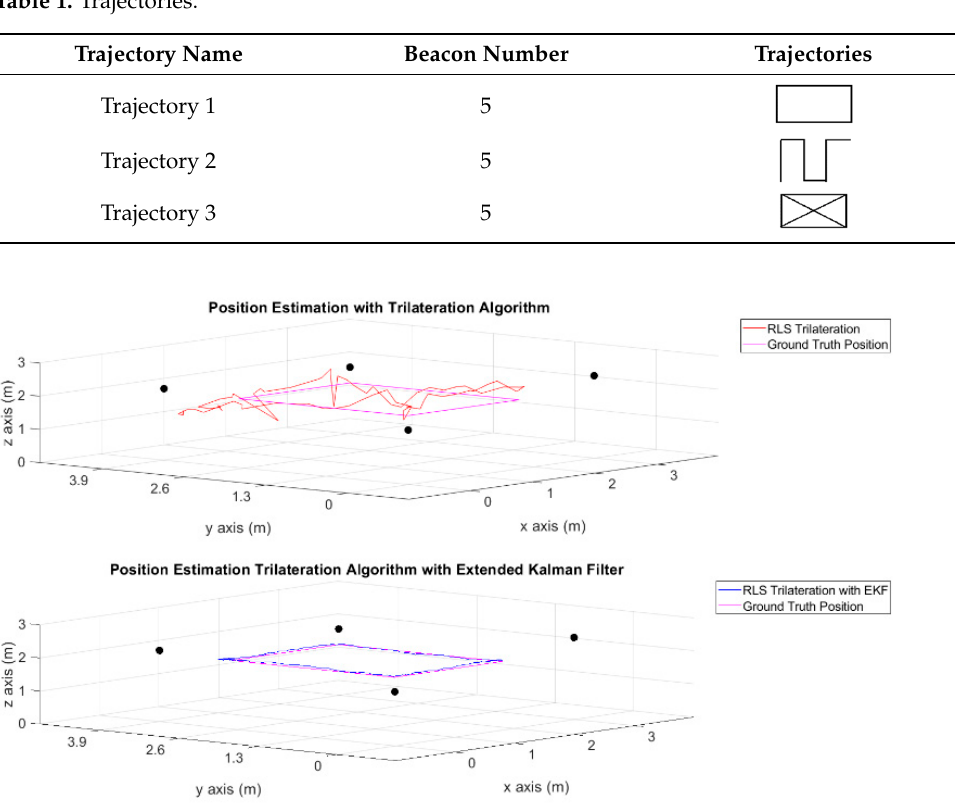
Figure 4. Position Estimation in Path 2 Trilateration Algorithm with and without EKF.